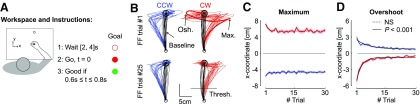

A, Illustration of the workspace and task. Participants were instructed to perform forward reaching movements toward a visual target. An open goal target was presented for a random delay uniformly distributed between 2 and 4 s before it was filled in. The cue to reach the target was given by filling in the goal in red. The goal was turned red if the time between the go signal and the stabilization in the target was comprised between 0.6 and 0.8 s. B, Hand paths from the first force field trials (top) and trial #25 selected for illustration (bottom) from each participant (n = 18). Counterclockwise and clockwise perturbations are depicted in blue and red, respectively. The black traces illustrate for each panel baseline trials selected randomly (one baseline trial per participant). Osh.: target overshoot; Max.: maximum displacement in the direction of the force field; Thresh.: the positional threshold used to align EMG data. C, Maximum displacement in the direction of the force field. The dashed trace illustrates that the exponential fit did not reveal any significant curvature across force field trials (p > 0.05). D, Maximum target overshoot in the direction opposite to the force field. Solid traces revealed strongly significant exponential decay across trials (p < 0.001).